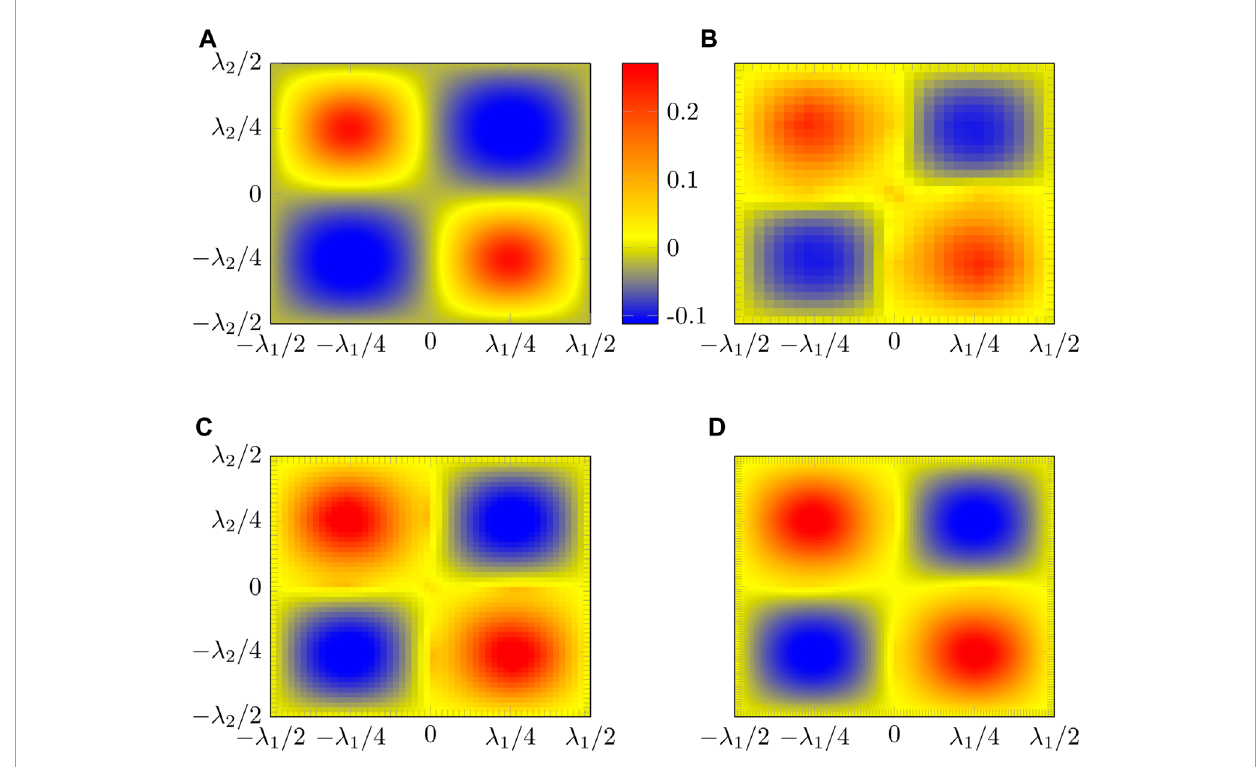
FIGURE 4 Strain concentration field A iijj ( x ) , i , j ,= 1 , 2 , 3, at the plane x i = λ i / 4, i , j ,= 1 , 2 , 3, obtained (A) analytically from Eq. 124 , and numerically by means of FFT (Lucarini et al., 2021) with (B) 32 3 voxels, (C) 52 3 voxels, and (D) 100 3 voxels.